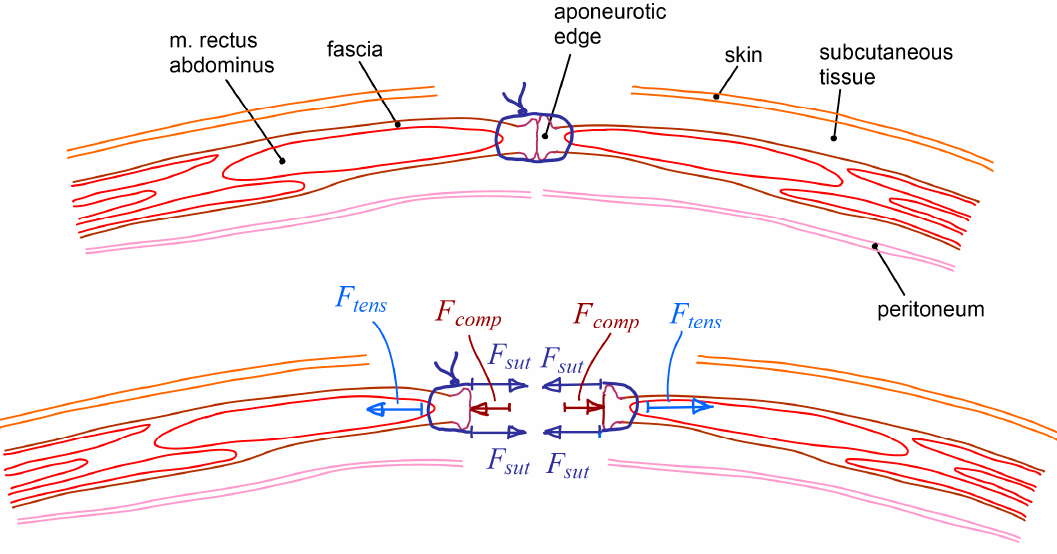
Figure 1. Common laparotomy closure and its acting forces.